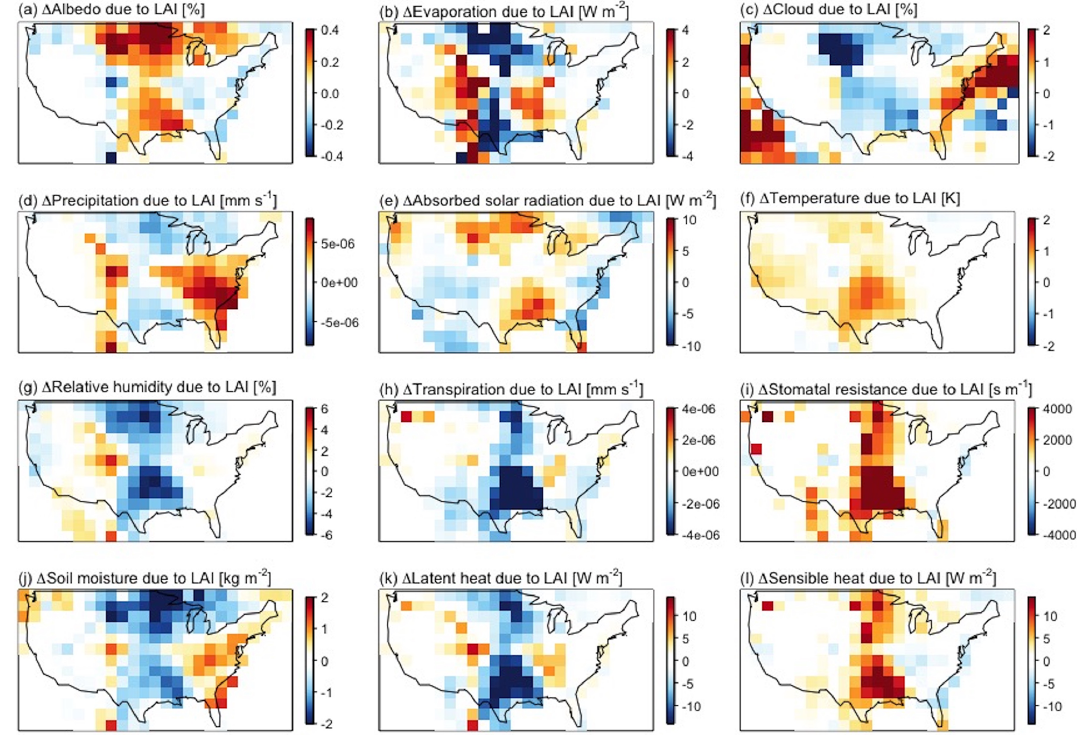
Figure 7. Summertime changes in (a) albedo, (b) ground evaporation, (c) cloud cover, (d) precipitation, (e) absorbed solar radiation, (f) surface temperature, (g) relative humidity, (h) vegetation transpiration, (i) stomatal resistance, (j) soil moisture, (k) latent heat flux, and (l) sensible heat flux driven by LAI increase with dynamic